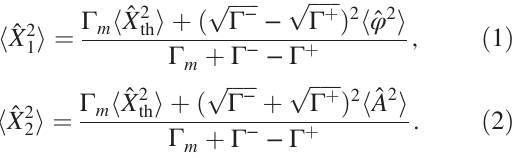
= 2 π ¼ 14 . 98 MHz. m ¼ ω (cid:1) Ω . 1 ; 2 m ; 2